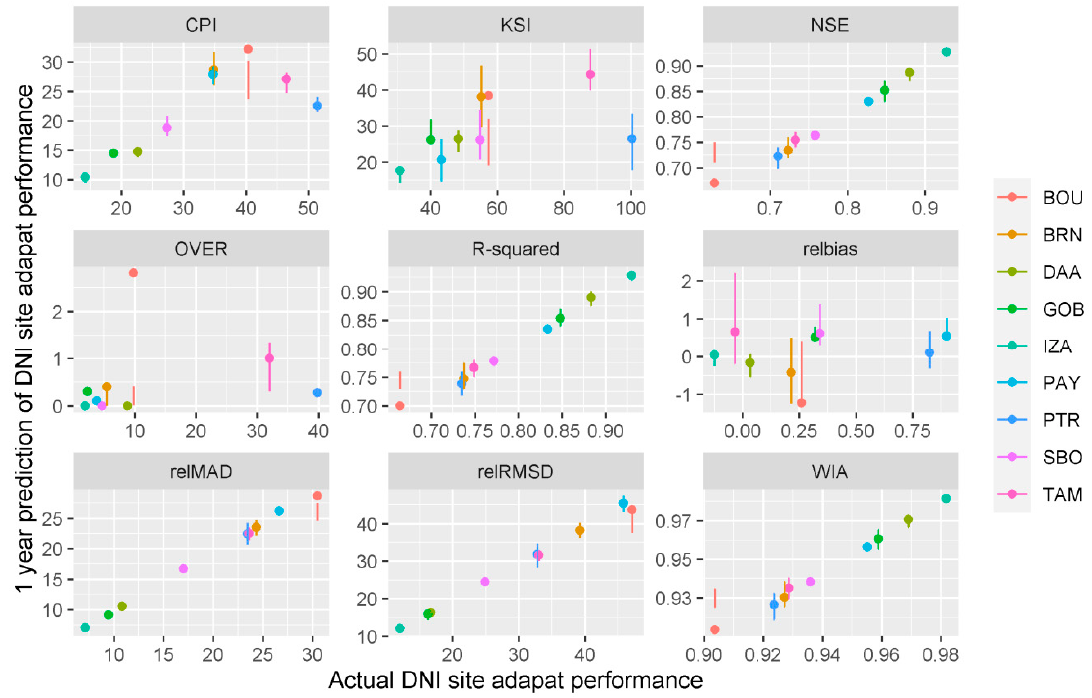
Figure 7. Scatter plots between statistical indicators of DNI site-adaptation performance calculated with 1 year of coincident measured and modeled data with respect to the actual values calculated in the whole period available.